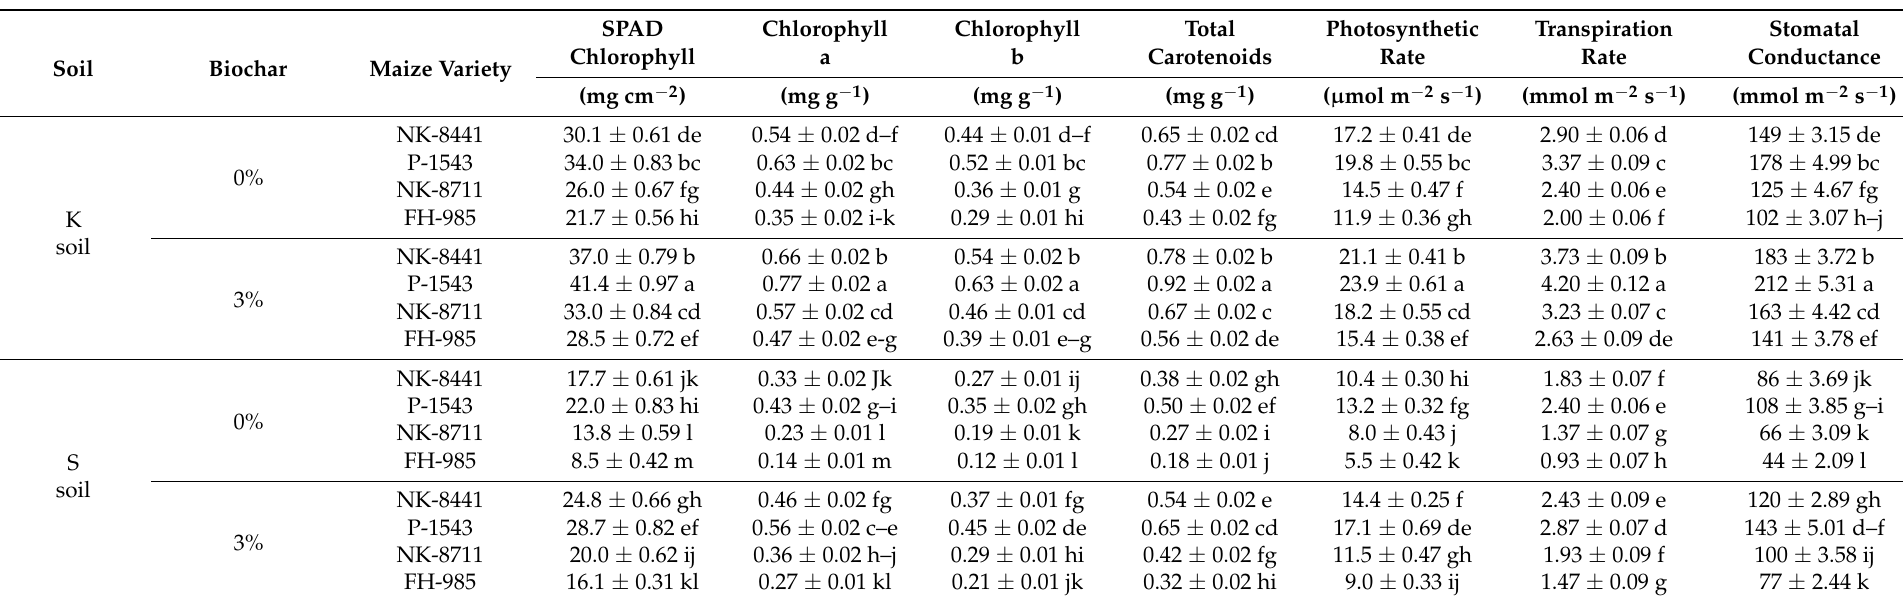
Table 4. Plant physiological parameters of maize cultivars NK-8441, P-1543, NK-8711, and FH-985 with the application of biochar in tannery polluted Kasur and Sialkot soils.